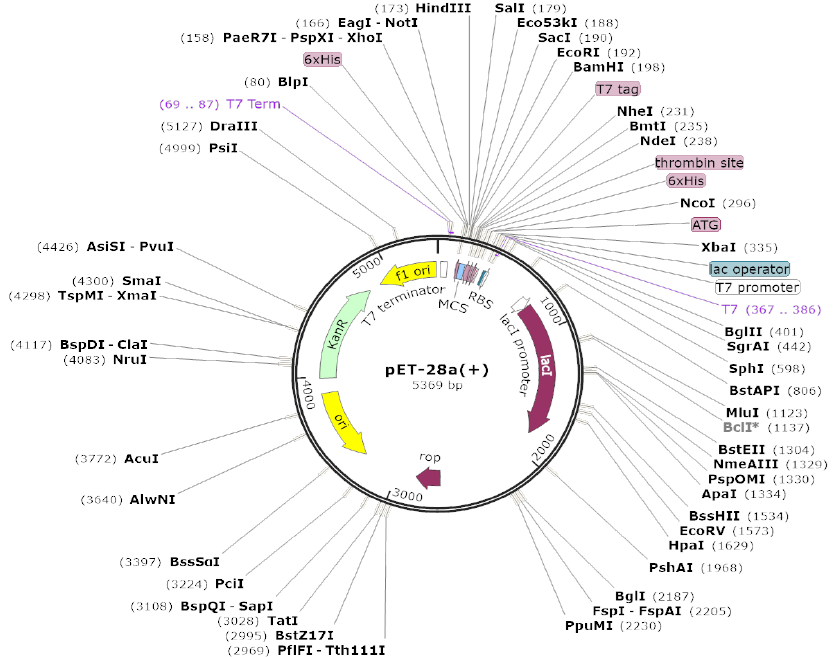
Figure A9. Map of the vector used for prokaryotic expression created with SnapGene. Different protein showed with distinguished color.